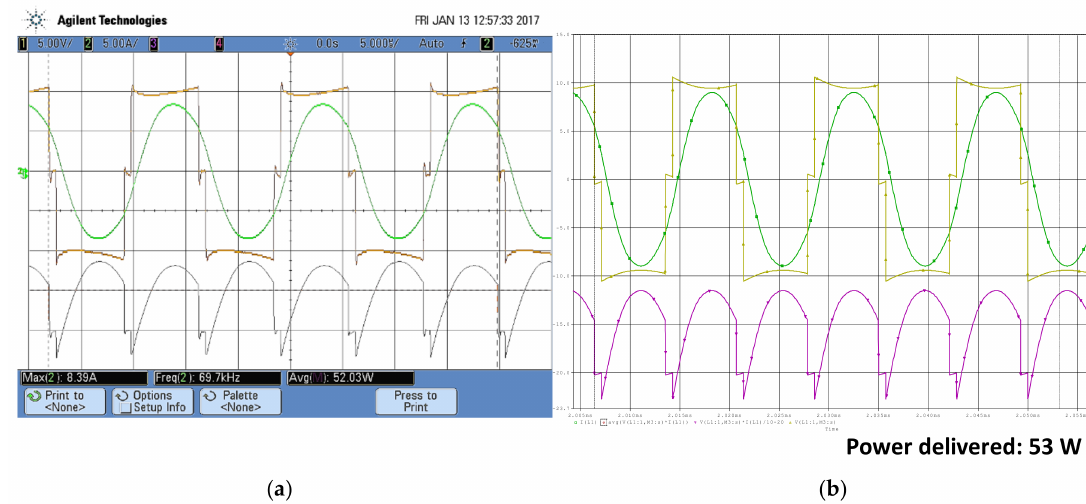
Figure 11. Experimental results ( a ) and simulation results ( b ). The efficiency is above 90% in the operation range. Battery 4S 4500 mAh, 25–50